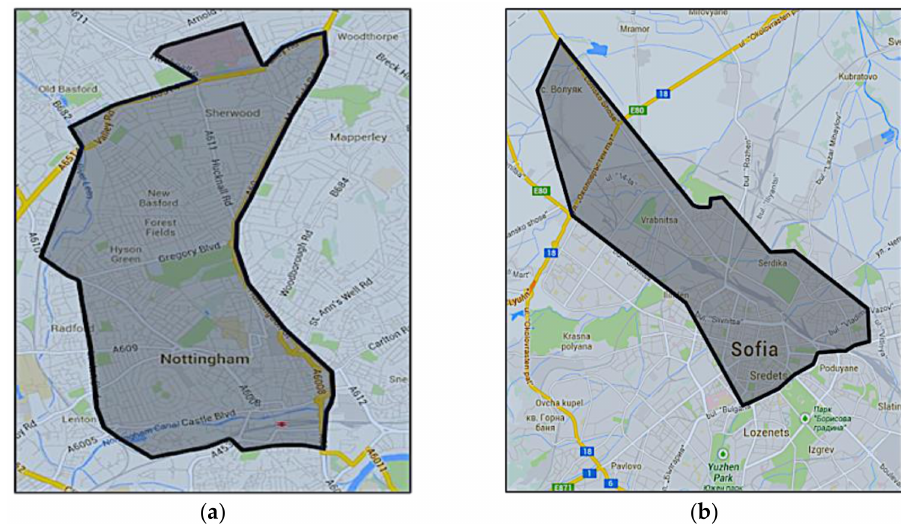
Figure 16. Study areas and commuting corridors in ( a ) Nottingham (United Kingdom) and ( b ) Sofia